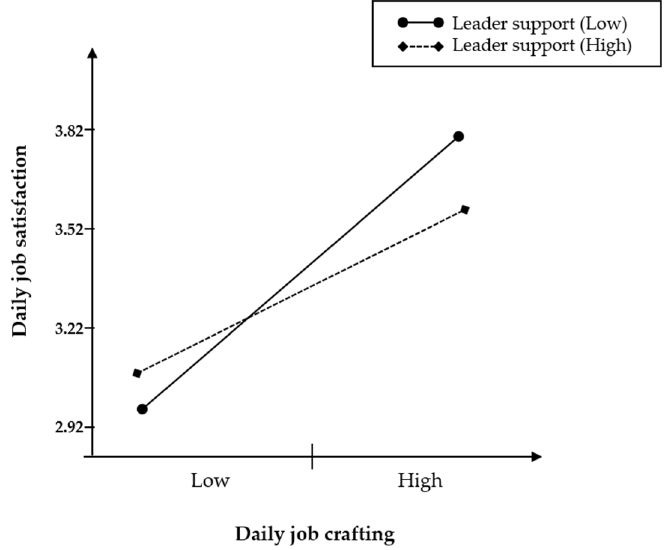
Figure 2. Cross-level moderating effect of daily job crafting and leader support on daily job satisfaction .